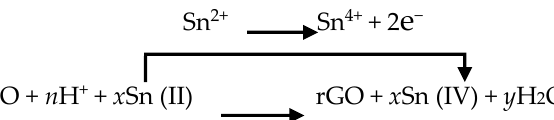
Figure 3. TG and DTG analysis of: ( a ) GO-Sn; ( b ) GO-Fe; ( c ) GO-Zn; ( d ) GO-Al; ( e ) GO-Mg; and ( f ) GO.